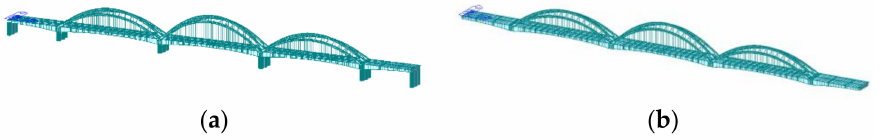
Figure 6. H-Q RB. ( a ) full bridge finite element model; ( b ) the upper structure finite element model.